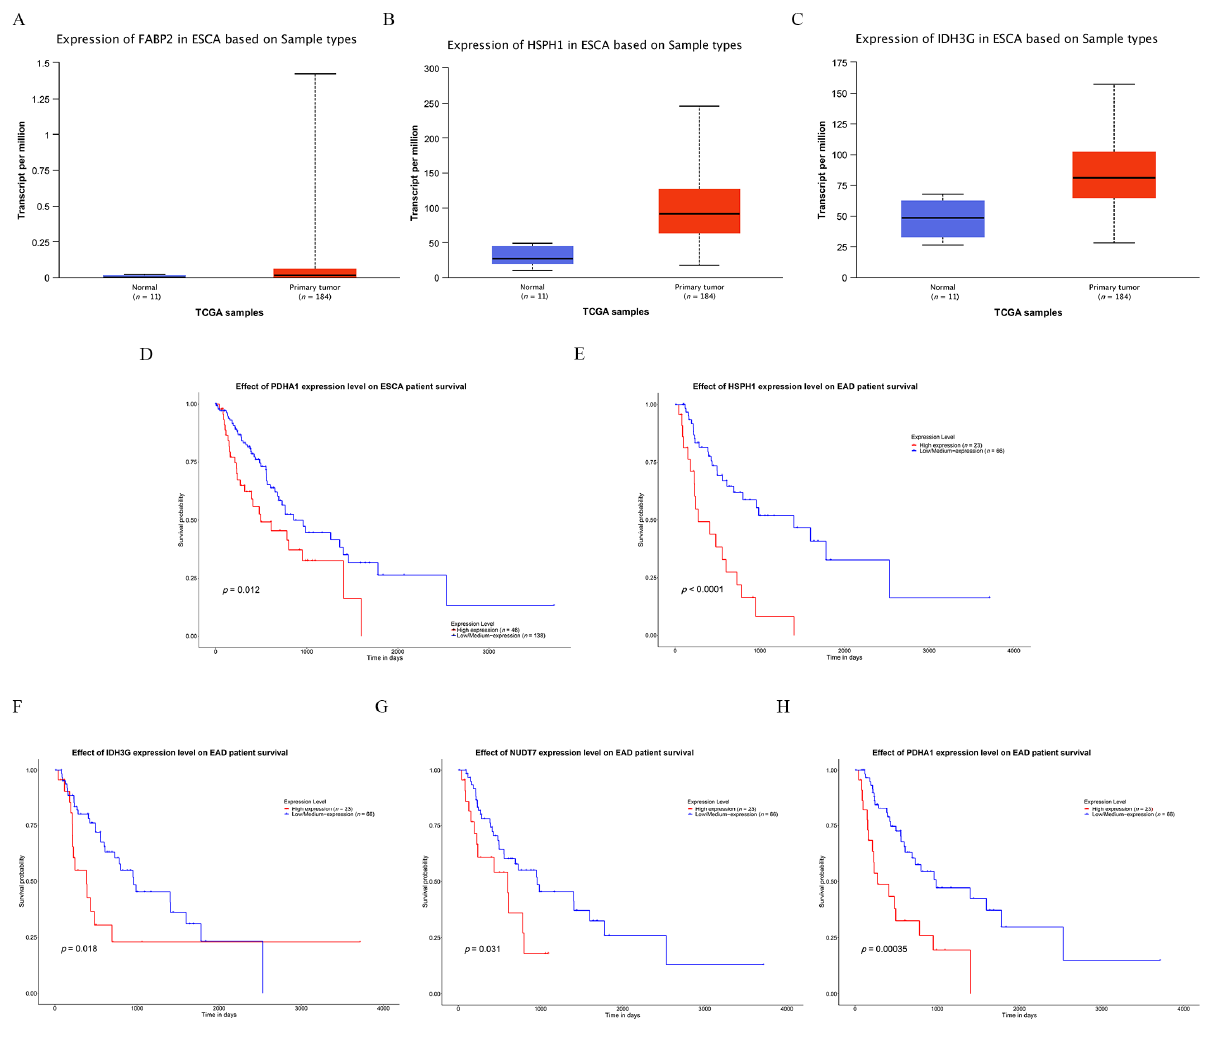
Figure 7. Validation the expression difference of the seven DE-FRGs and their prognostic value. ( A – C ) Confirmation of the expression of FRGs in ESCA. ( A ) FABP2, ( B ) HSPH1 and ( C ) IDH3G. ( D ) High PDHA1expression was correlated with poor OS in ESCA. (E–H) Survival rates were calculated between high and low gene expression groups in EAD patients. ( E ) HSPH1, ( F ) IDH3G, ( G ) NUDT7 and ( H ) PDHA1. EAD = Esophageal adenocarcinoma.